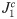
Sufficiently strong structure yields transition out of chaos despite row balance.(A) Scatterplot of the logarithm of transitional value, J1c, vs the absolute value of the projection of the output mode, ν, on the leading eigenvector, u(1) for 300 connectivity realizations with N = 8000. r2 = 0.29. (B) Fraction of realizations displaying chaotic activity as a function of the rescaled structured connectivity: J1N. With this scaling the curve appears to be independent of N.